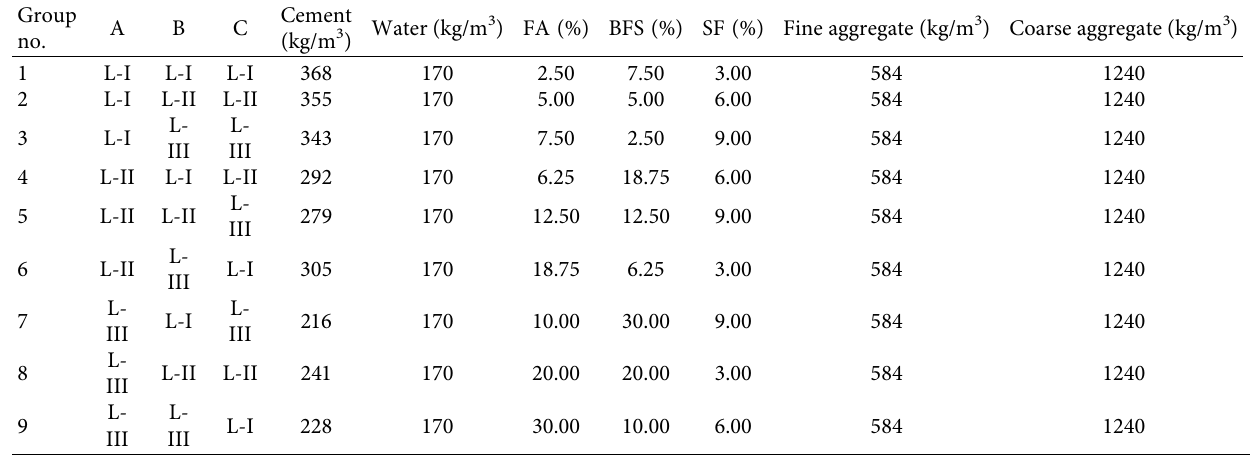
Table 4: Mix proportions of concrete with multiadmixtures (kg/m 3